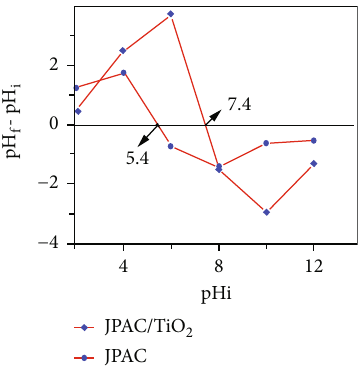
Figure 2: Point of zero charge plot of adsorbents by drift